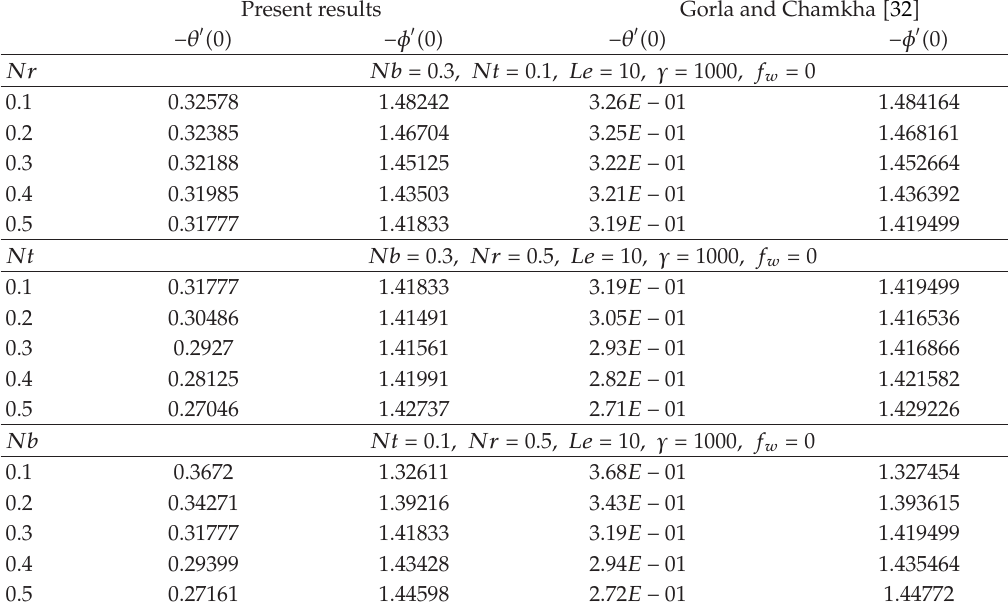
Table 1: Comparison of present results with Gorla and Chamkha (cid:5) 32 (cid:6) for di ff erent values of buoyancy and nanofluid parameters.